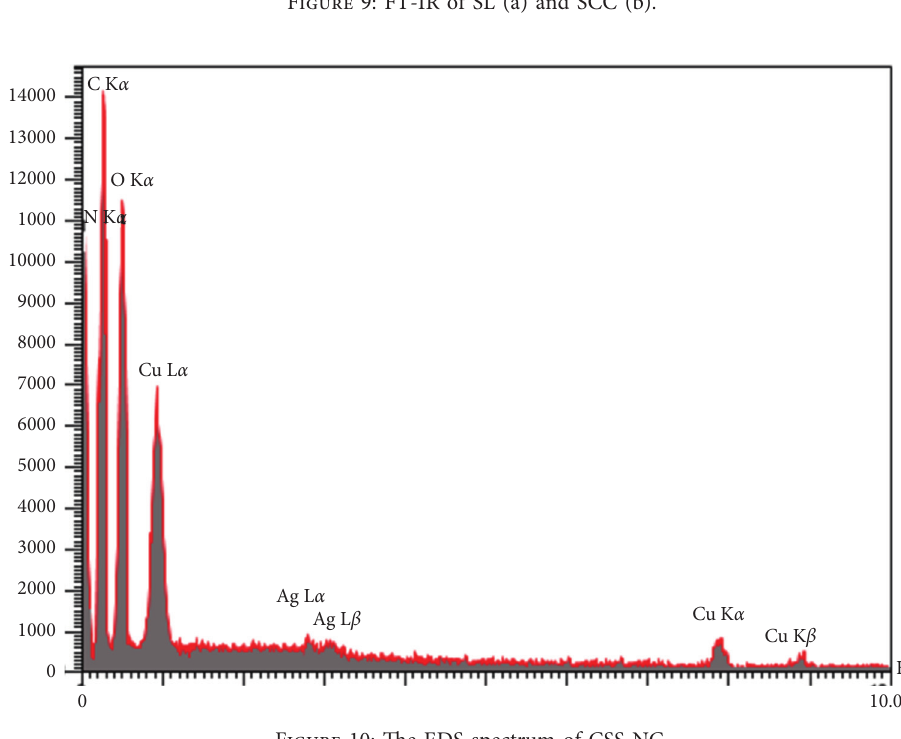
Figure 9: FT-IR of SL (a) and SCC (b).